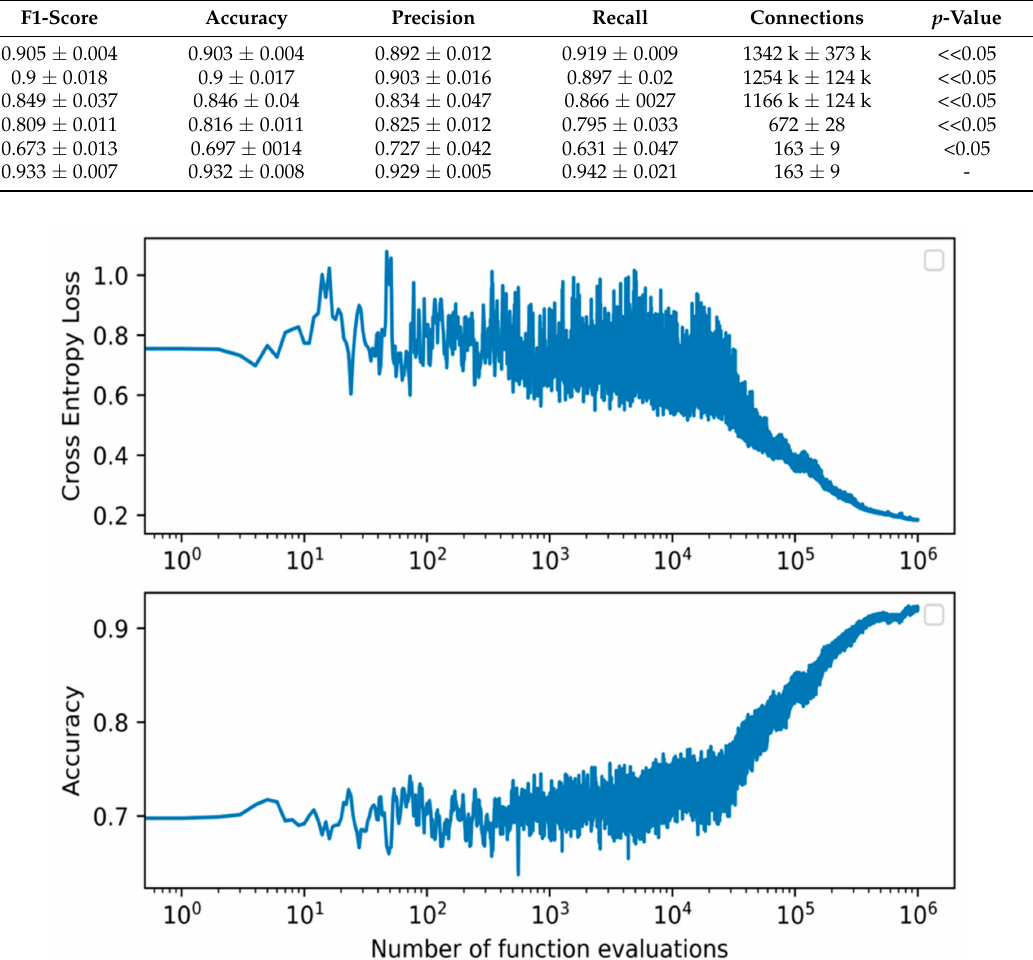
Table 4. The summary of the results on the test set for all models. Each model was trained three times, in which a different random number generator seed was used each time, and the metrics presented are the average and standard deviation of those runs.